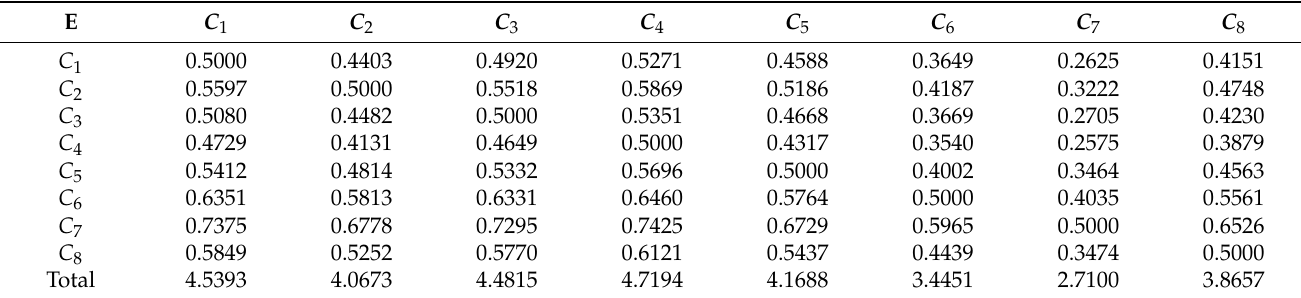
Table 6. Aggregated pairwise comparison matrices of 16 evaluators.